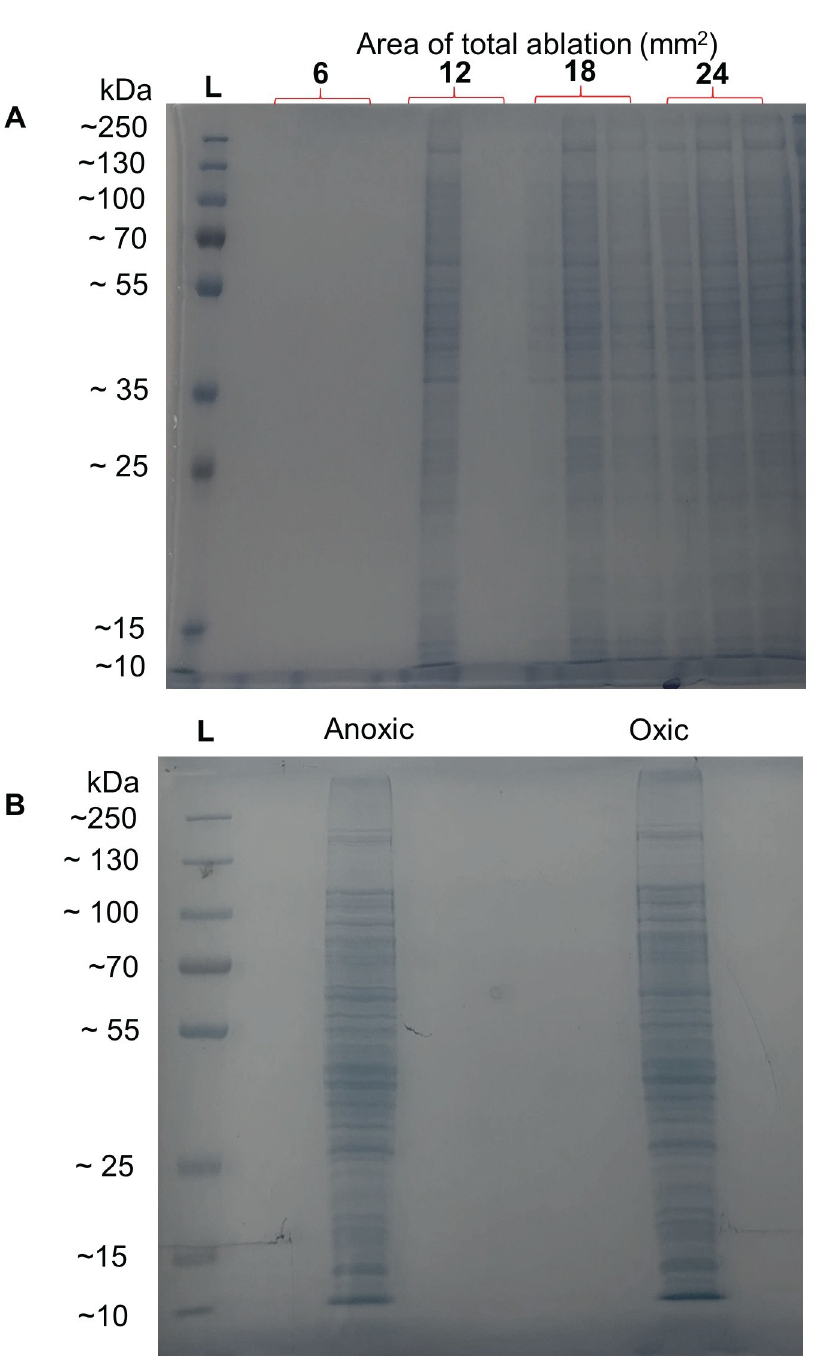
Fig 4. Gels from SDS-PAGE of cell lysates from laser ablated biofilms. A) Preliminary identification of the presence of proteins in cell lysates from biofilms grown on polycarbonate membranes, collected by laser ablation from 6–24 mm 2 total biofilm area. B) Confirmation of proteins in cell lysates collected by laser ablated from anoxic (left) and oxic (right) 24 mm 2 area regions of biofilms grown on transwell membranes. Protein bands of gel lanes were subsequently excised for in-gel digestion and bottom-up proteomic